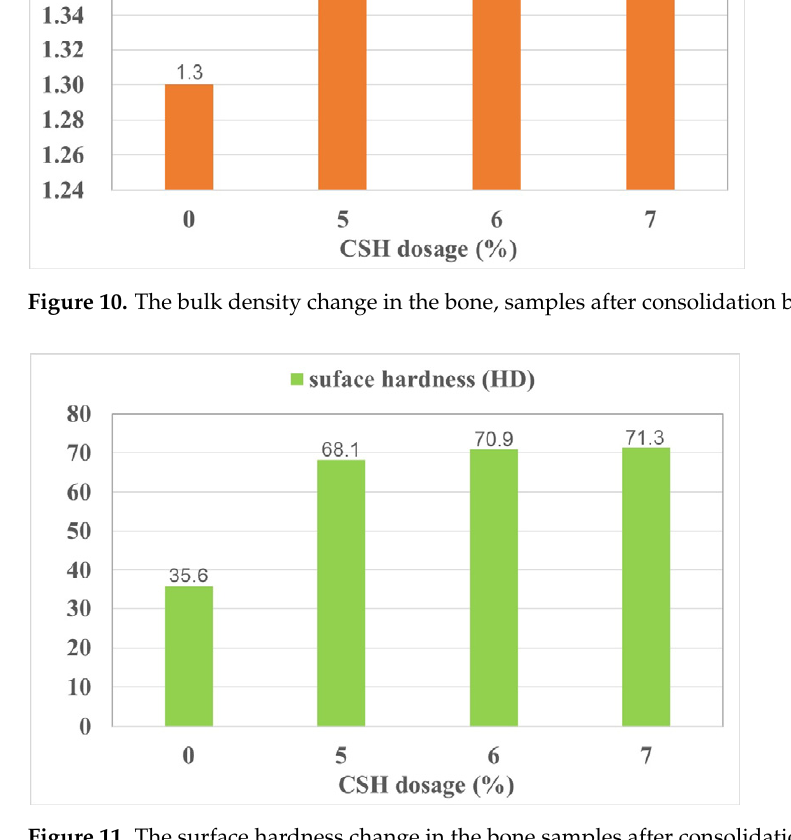
Figure 12. The color difference change in the bone samples after consolidation by CSH. 4. Conclusions In this paper, nano CSH was successfully prepared by the reaction of calcium chlo- ride and sulfuric acid in ethylene glycol solution. It was then re-dispersed in an alcohol solvent to obtain a suspension liquid with high kinetic stability and explored as a protec- tive material for bone relics. In application, the suspension of CSH was first introduced into the bone samples, followed by the introduction of water, which hydrated the CSH into a continuous phase of CSD, filling the open pores, bridging the cracks, and providing additional strength for the weak bones. After the consolidation treatment, the porosity of the bone samples reduced, the strength of the bone samples increased, and the appearance change of the samples was acceptable. However, due to the low durability of gypsum in the open air, the proposed protective material is appropriate only for indoor porous weak bone objects and cannot be applied to any unsheltered or semi-sheltered objects. Author Contributions: Conceptualization, F.Y.; Data curation, Y.L., R.L., L.H., X.W., L.W. and X.L.; Investigation, Y.L., R.L., L.H., L.W., X.L. and K.Z.; Methodology, F.Y.; Writing—original draft, Y.L.;